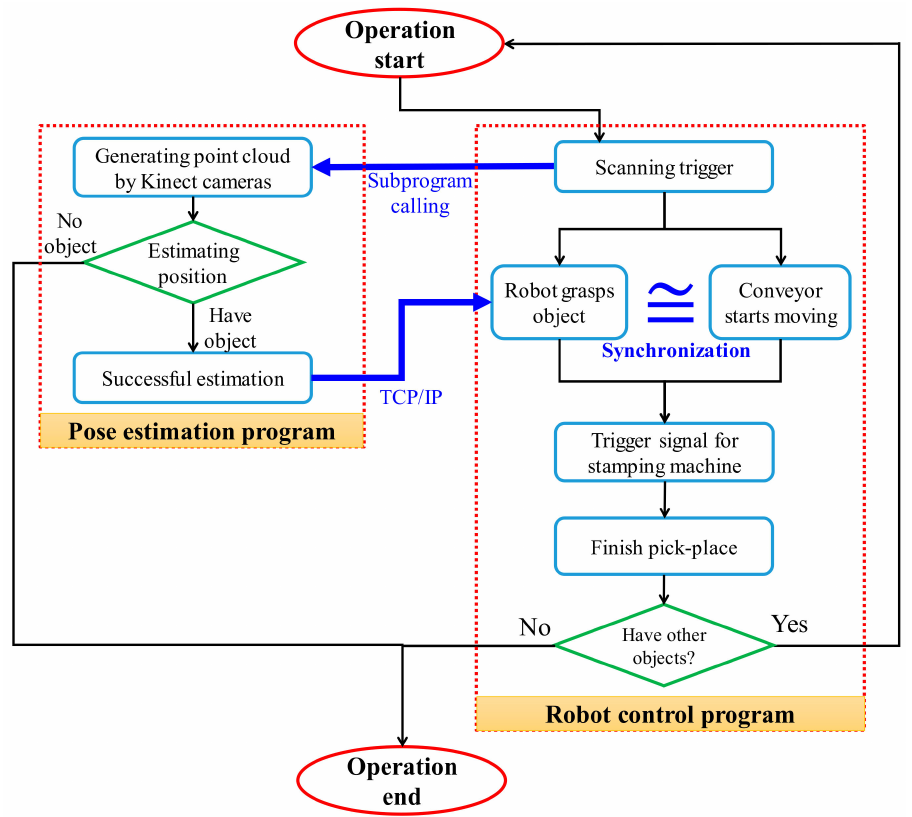
Figure 17. Flow chart of pose estimation and robot control programs for the dynamic workpiece feeding control system.